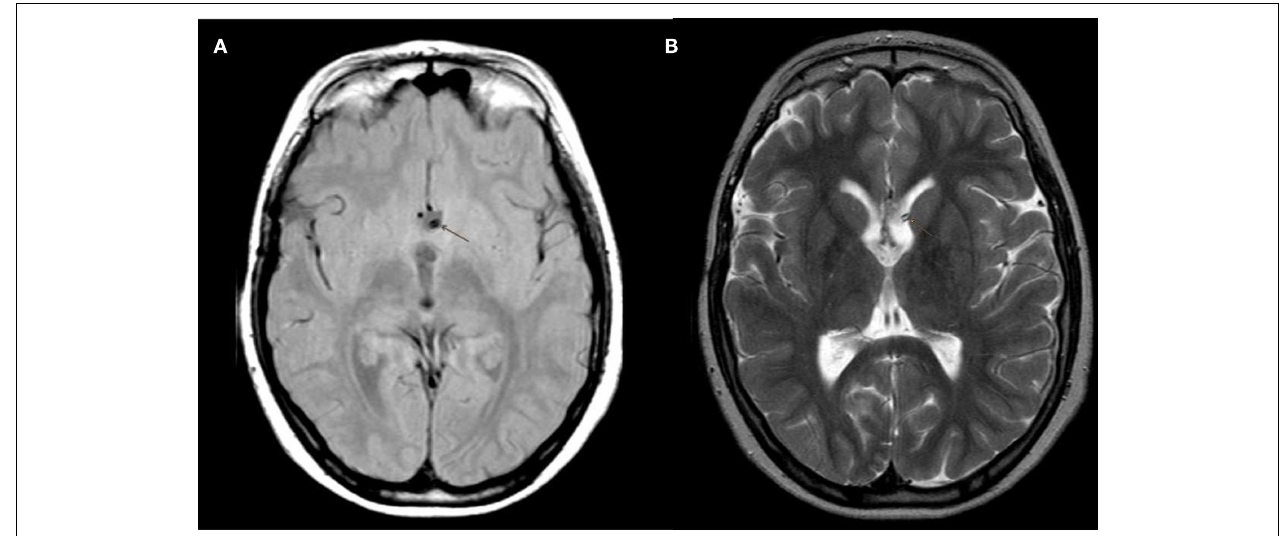
FIGURE 3 | (A,B) Postoperative MRI (T1 andT2 weighted) control showing the Rickham catheter for internal drainage ending in the shrunken hypothalamic